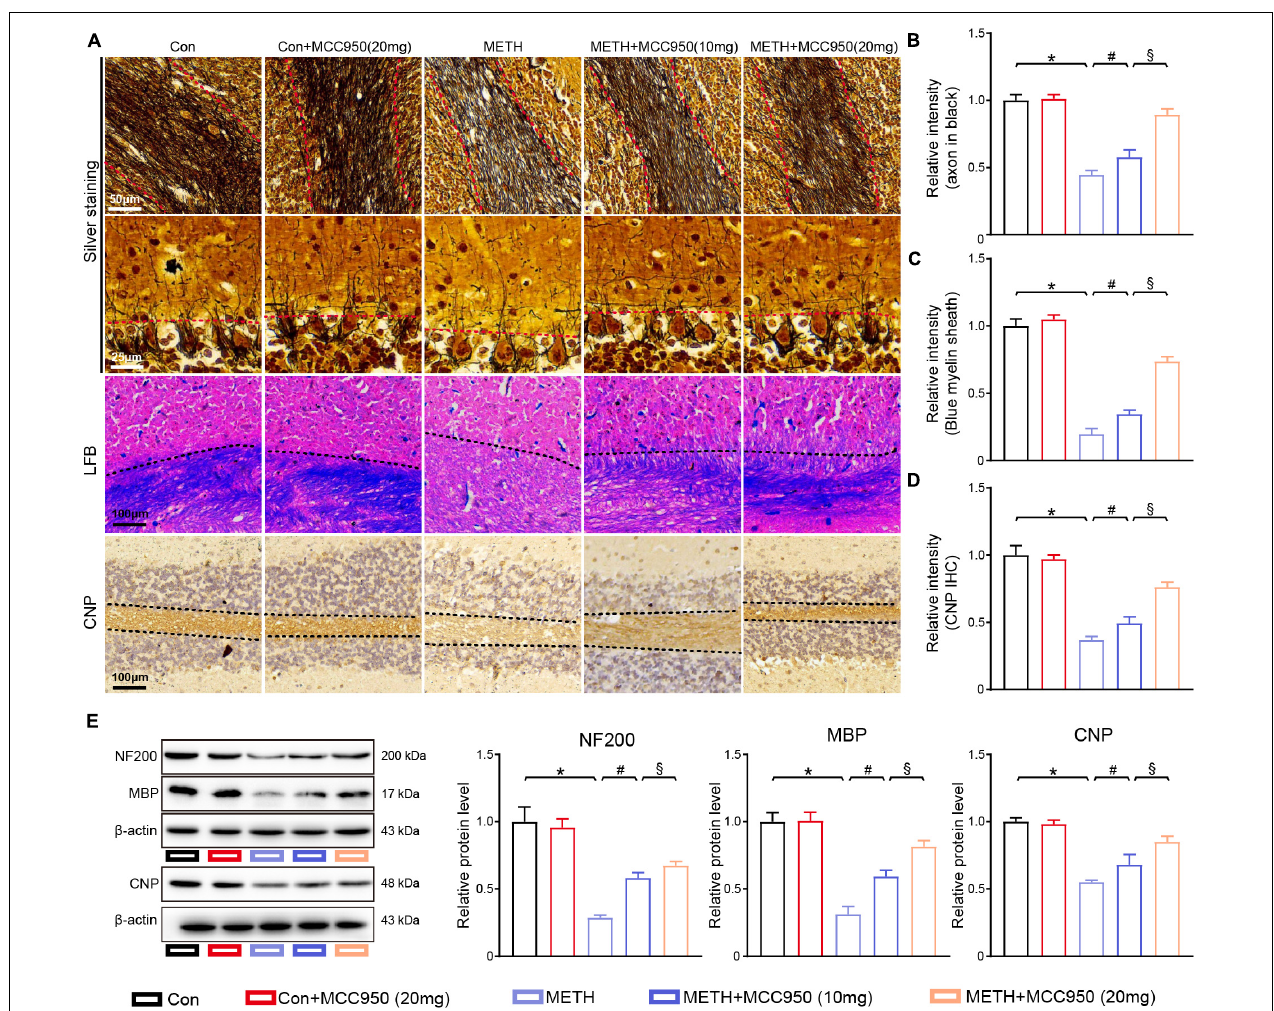
FIGURE 4 | MCC950 diminished the axon degeneration and myelin loss in cerebellum. (A) Representative images of silver staining, LFB staining, CNP IHC staining in cerebellar areas. (B) Intensity of axons analysis. (C) Myelin sheath intensity analysis. (D) Relative intensity of CNP in cerebellar areas. (E) Western blot and quantification for NF-200, MBP, and CNP in cerebellum. n = 6 per group by one-way ANOVA and Bonferroni’s post-hoc analysis, * p < 0.05, compared with the Con group; # p < 0.05, compared with the METH-treated group; § p < 0.05, compared with the METH + MCC950 (10 mg)